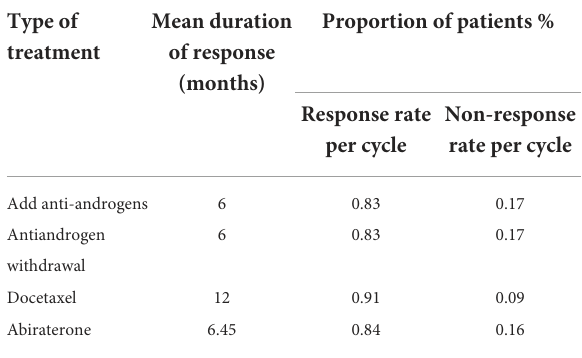
TABLE 3 The response rates of second-line treatment.